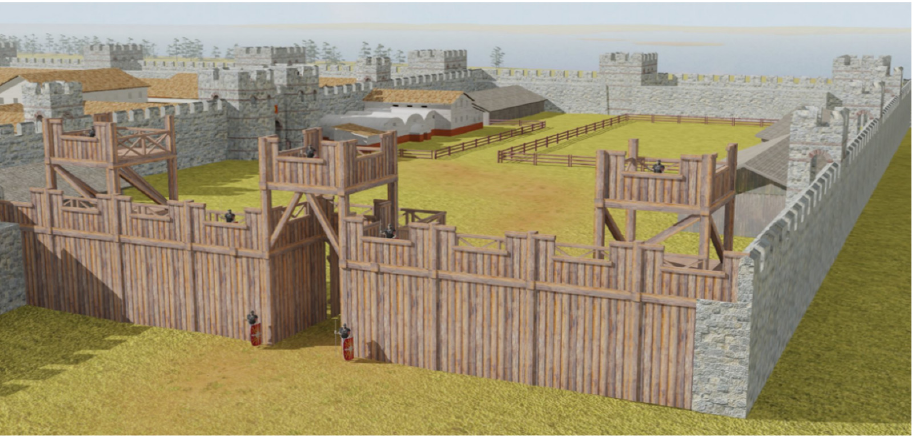
Figure 8. Reconstruction of area 2 behind the eastern wall of the castellum with garrison baths, and buildings for various purposes.